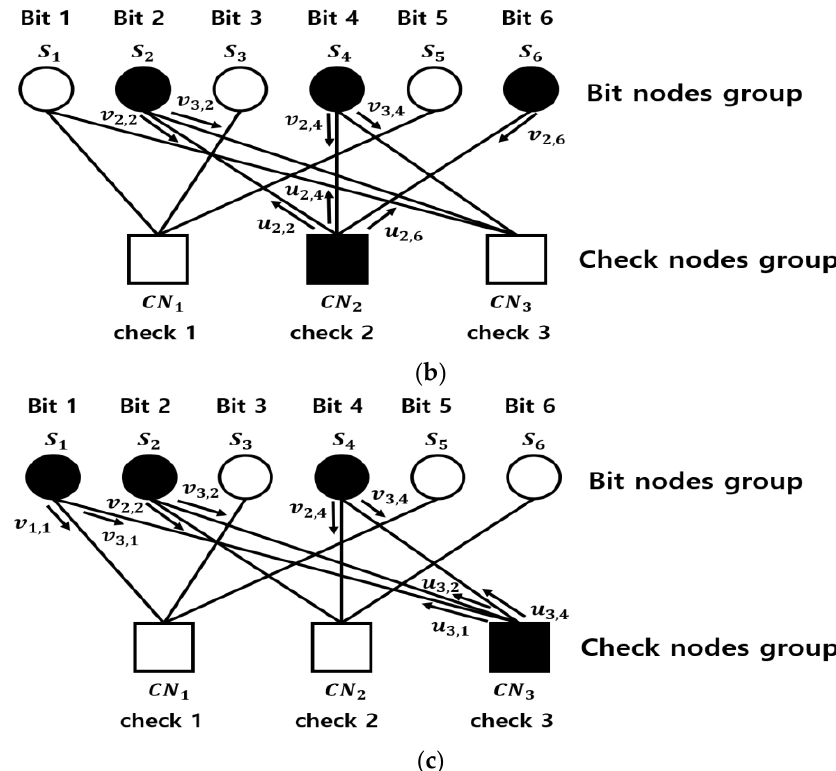
Figure 5. Tanner graph and the HSS-based LDPC decoding process: ( a ) Step 1: first check of the node update; ( b ) Step 2: second check of the node update; ( c ) Step 3: third check of the node update. u , which are linked from the th i i,j